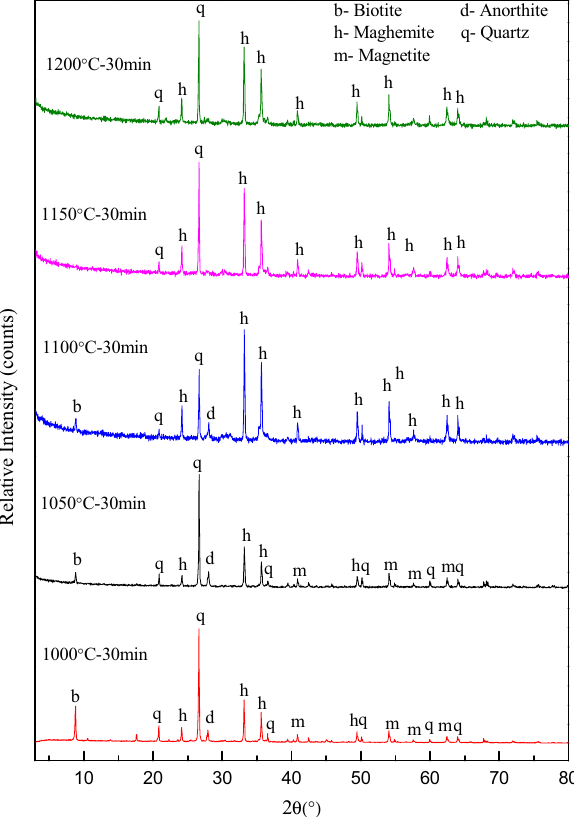
Figure 8: XRD spectra of roasted slag at di ff erent roasting